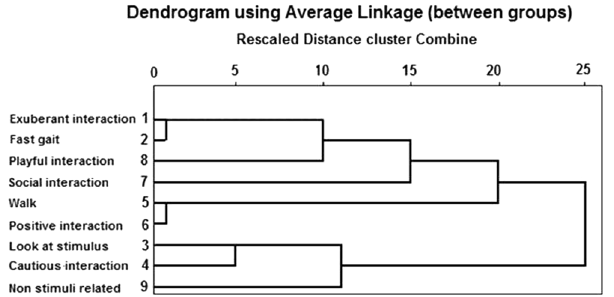
Figure 1. Agglomeration dendrogram. The branching-type graph illustrates the results of the Hierarchical Cluster Analysis. To find which variables are clustering at a given step, trace backwards down the branches to the variable name. The 0 to 25 scale along the top of the chart is a measure of the relative distance between clusters. The bigger the distances before two clusters are joined, the bigger the differences between these clusters.